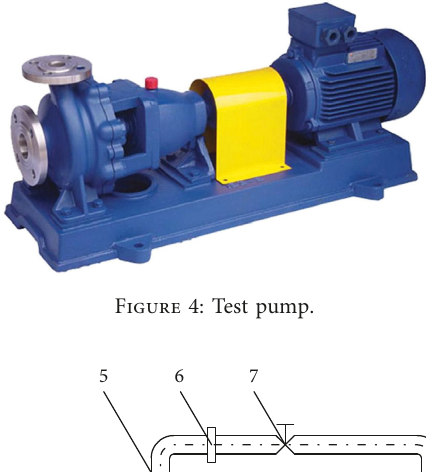
Figure 4: Test pump.